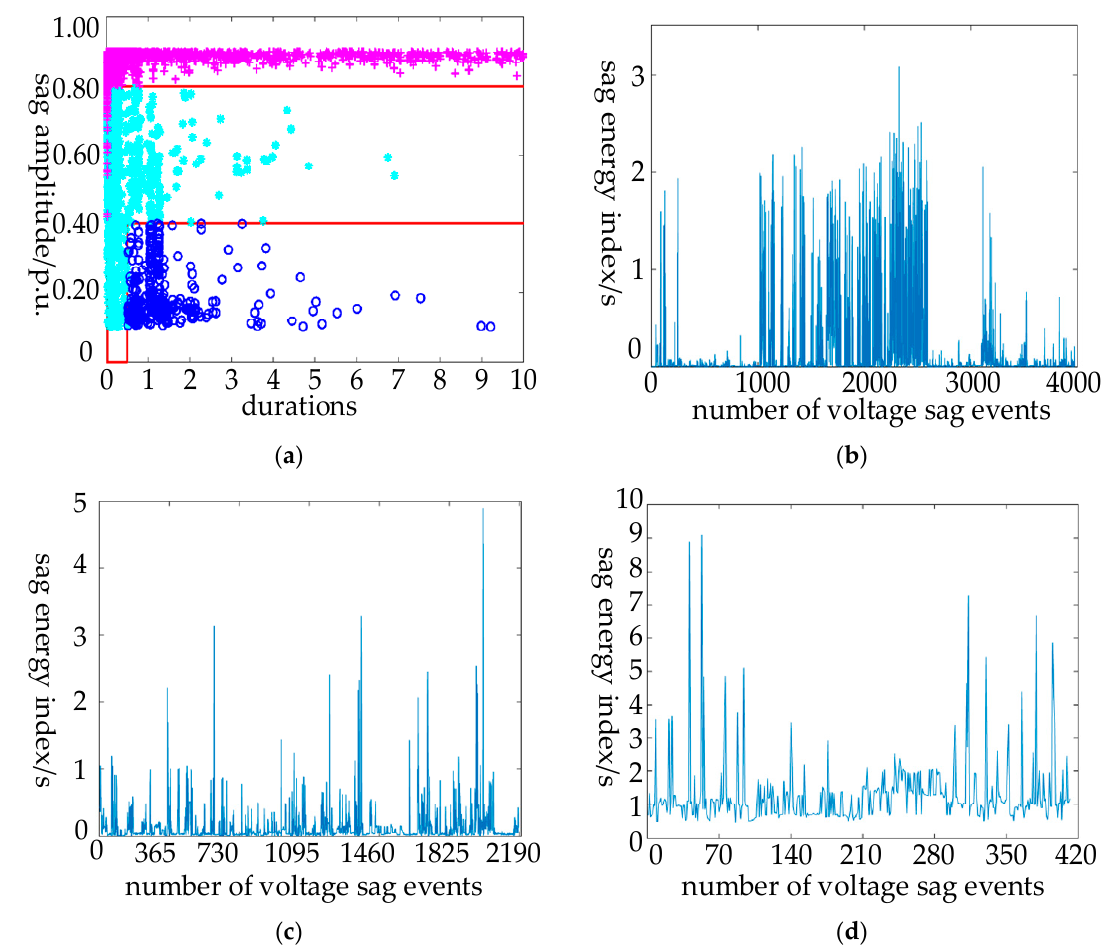
Figure 3. Distribution characteristics of voltage sag events and energy index values: ( a ) Scatter plot of sag event distribution; ( b ) Energy index value of the sag event in the normal area; ( c ) Energy index value of the sag event in the uncertainty area; ( d ) Energy index value of the sag event in the abnormal area.